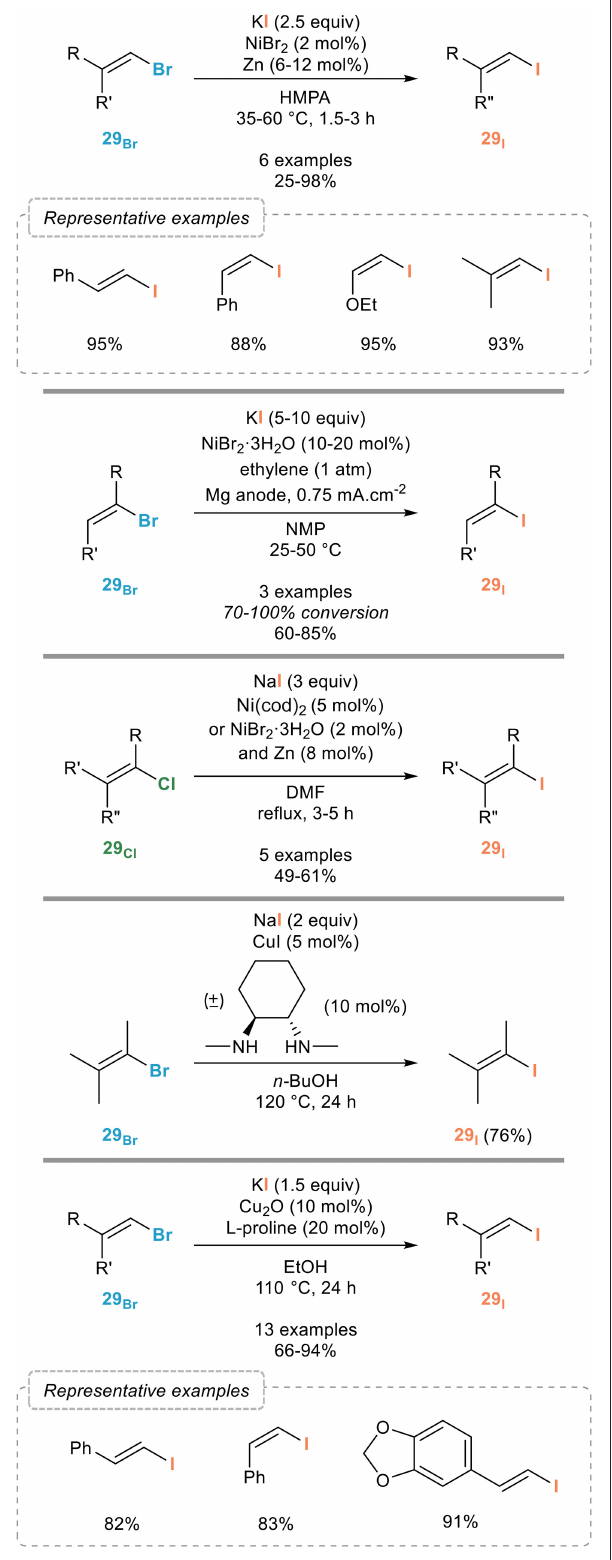
FIGURE 16 | Vinylic Finkelstein